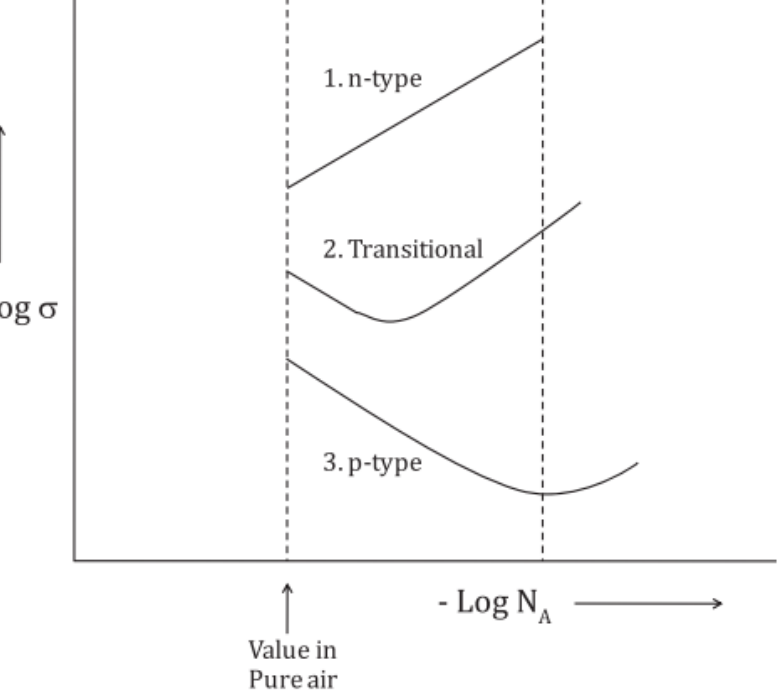
Figure 3. Conductivity dependence on the concentration of analyte (represented by the surface acceptor state density N A per unit volume) for three materials with different bulk donor density N D . Reprinted with permission from Ref. [13]. Copyright 2017, IOP Publishing.